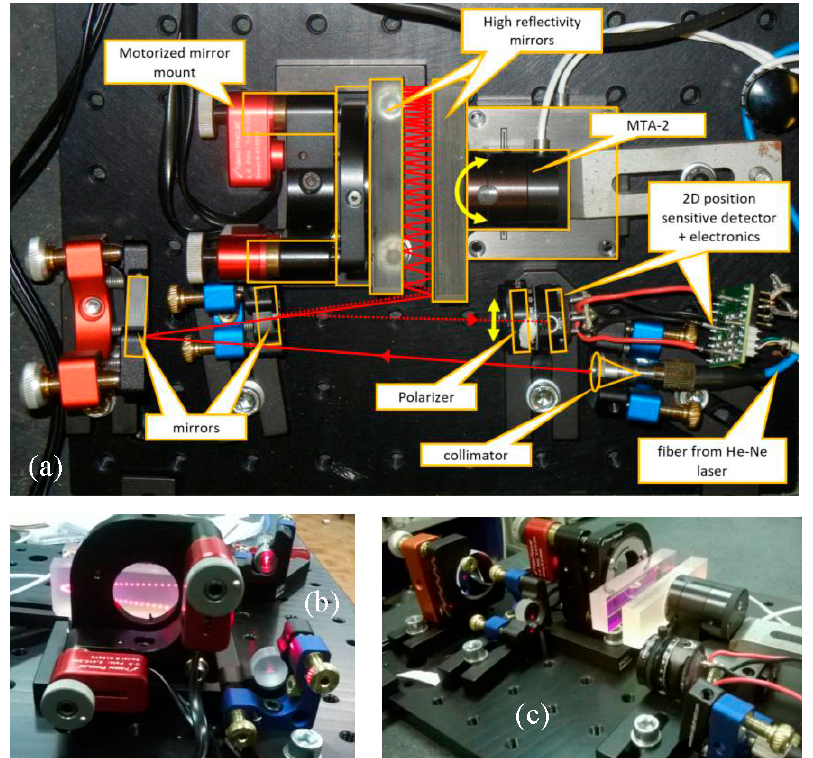
Figure 2. Pictures of the experimental set-up. ( a ) top view with the laser path drawn on the picture: the entering laser beam (solid red line) is sent towards the multiple reflection mirrors where the angle amplification occurs (see text for the details). The contours in orange indicate the main optical components and the yellow arrows indicate the movement of the MTA-2 and the translation of the beam; ( b ) back view of the angle amplification (AA); the multiple reflection pattern is visible at the back of the “reference” mirror. ( c ) side view of the AA; the device under test (DUT) holding the “measurement” mirror is visible at the top right.